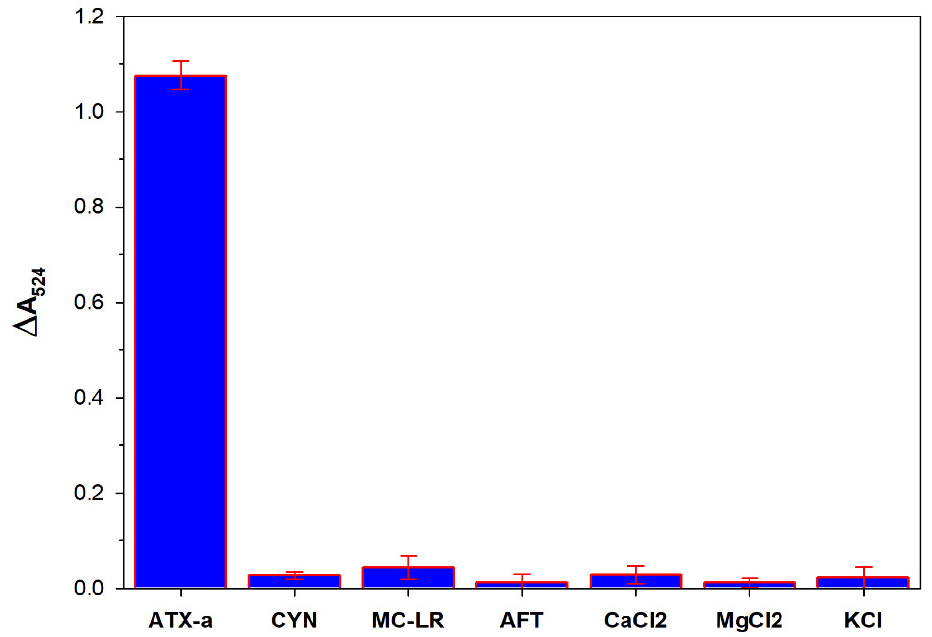
Figure 7. Specificity of the proposed colorimetric aptasensor for anatoxin-a (ATX-a). The ATX-a concentration was 200 nM. The concentration of other interferents was 1 µM.